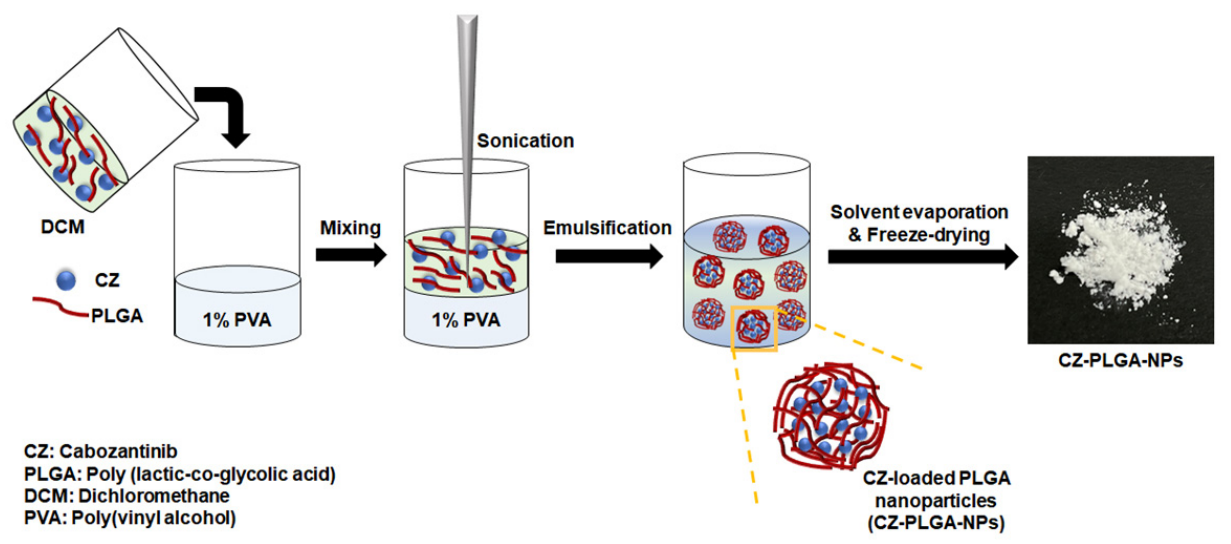
Figure 2. Schematic illustration of the preparation of CZ-PLGA-NPs, including the CZ encapsulation process into PLGA-NPs.